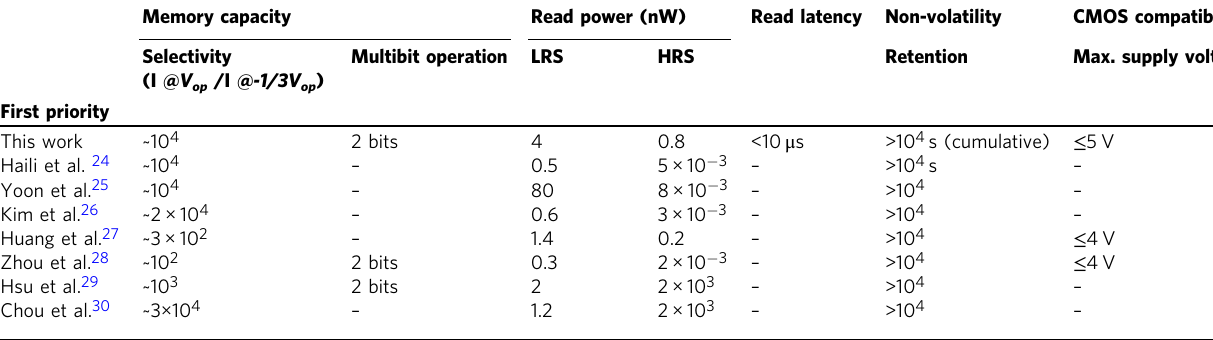
Table 1 Performance comparison between our SRMC and previous